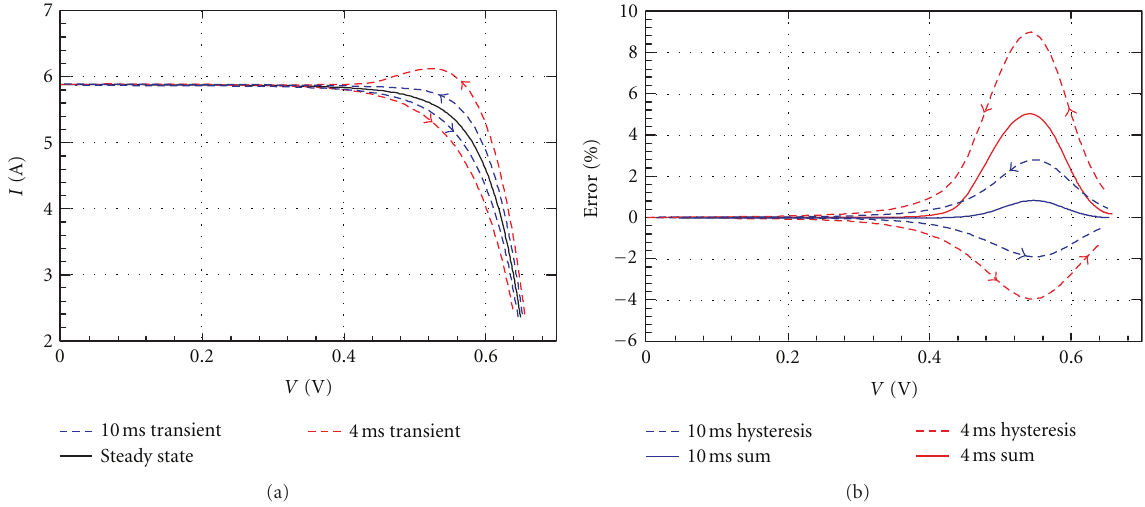
Figure 1: The I-V curve hystereses due to the forward and reverse sweep (a) and the corresponding errors caused by the internal capacitance (b) of a back-contacted monocrystalline silicon solar cell (arrows indicate the direction of the sweeps).